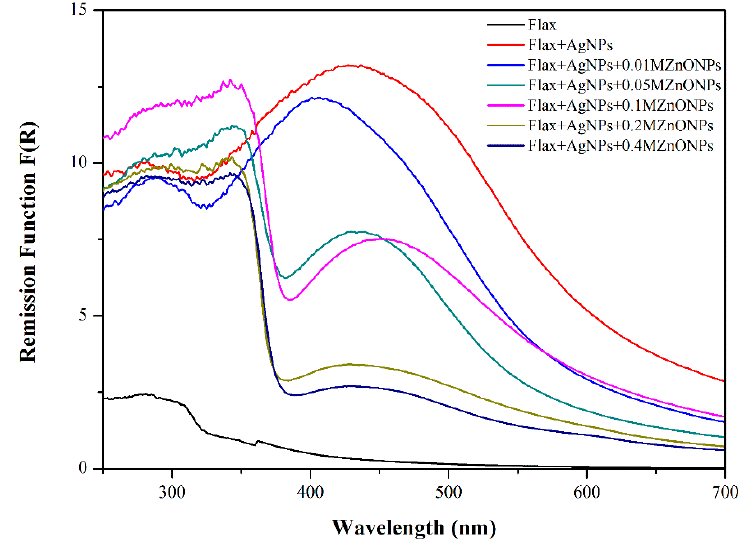
Figure 2. Ground State Diffuse Reflectance (GSDR) spectra of flax fabric treated with silver nanoparticles (AgNPs) and different concentrations of zinc oxide nanoparticles (ZnONPs). Flax fabrics functionalized with AgNPs exhibit a peak at approximately 437 nm, which indicates the surface plasmon resonance (SPR) band formation of AgNPs. In the flax fabrics’ spectra treated with both Ag and ZnO NPs it is visible the appearance of a new absorption band at UV region (~380 nm), characteristic of ZnONPs. Furthermore, the sharp shape of the ZnONPs absorption band indicates that these NPs are monodispersed [21,22]. Nevertheless, as the concentration of ZnONPs precursor increases (from 0.05 M to 0.4 M), there is a decrease in the intensity, broadening, and shifting of the AgNPs absorption band. This phenomenon can be related with the increasing size of NPs (as will be shown with FESEM analysis), with the highest quantity of ZnONPs as compared with AgNPs and with the presence of AgNPs agglomerates/nanoclusters [5,23]. At the same time, with the second process (ZnONPs functionalization), AgNPs that are not so strongly attached to the fabric surface are lost, decreasing the absorption band intensity. The in-situ synthesis of ZnONPs onto flax fabric is performed after synthesis and deposition of AgNPs onto flax. Firstly, the AgNPs are incorporated onto the flax fabric, the samples are washed and dried. After this, the flax fabrics with the AgNPs are subjected to the in-situ synthesis of ZnONPs in solution and using NaOH as reducing agent. It is normal that during this process, the AgNPs that are not so strongly attached to the surface are lost due to the use of NaOH and also due to the stirring process,which is why the intensity of the